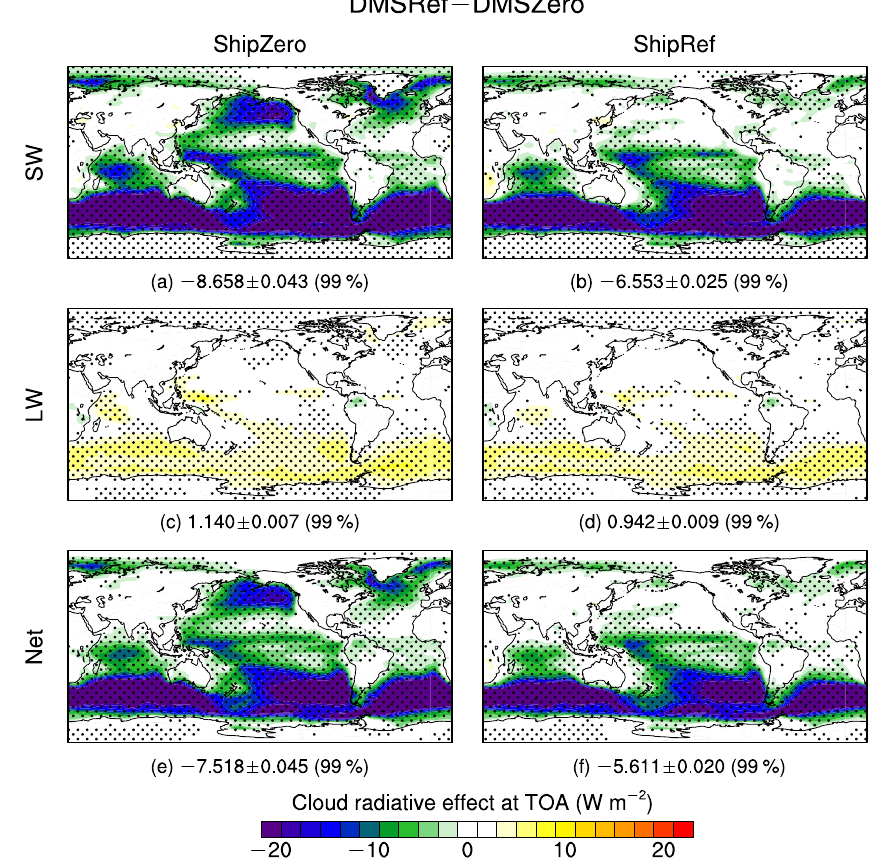
Figure 9. Spatial patterns of MARC-simulated cloud radiative effect (Wm − 2 ) of DMS emissions at various shipping emission levels. The CRE is calculated as the differences of radiation flux at the TOA and at all-sky conditions between the simulation without DMS emissions and two simulations with the same DMS emissions at the reference level but various shipping emission levels (i.e., zero and reference) in short-wave (SW), long-wave (LW), and net (SW + LW) radiation and averaged over the 30-year simulation period. The numbers below each panel are the global means, standard deviation across the 30-year period, and the confidence level. The black dots represent grid points that are statistically significant above the 90% confidence level based on the two-tailed Student’s t test.